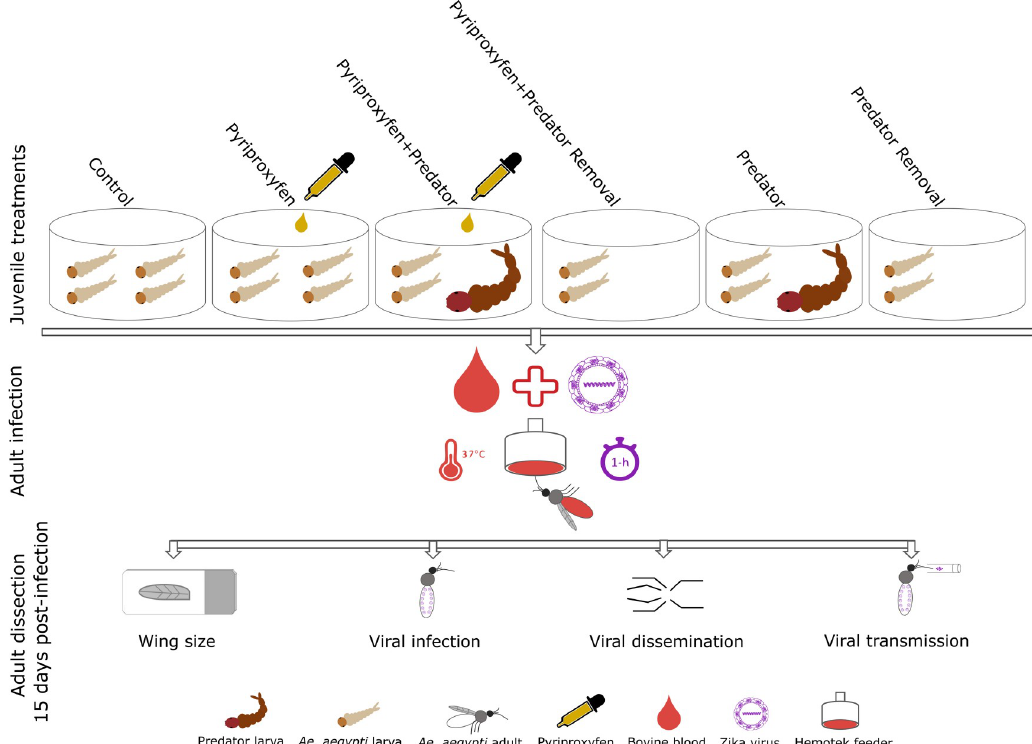
Fig 2. Schematic diagram illustrating the experimental